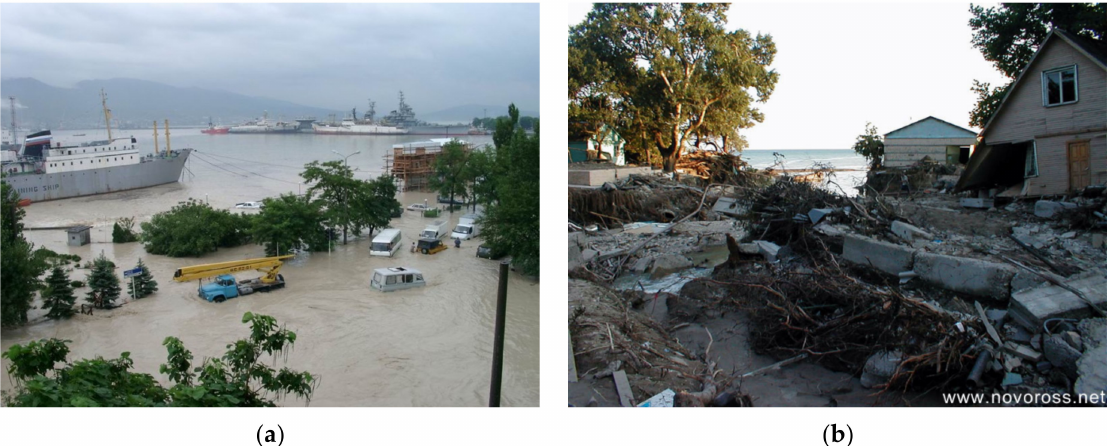
Figure 9. ( a ) Flooded streets and embankment in the center of Novorossiysk on 8 August 2002; ( b ) damaged tourist infrastructure in Shirokaya Balka on 8 August